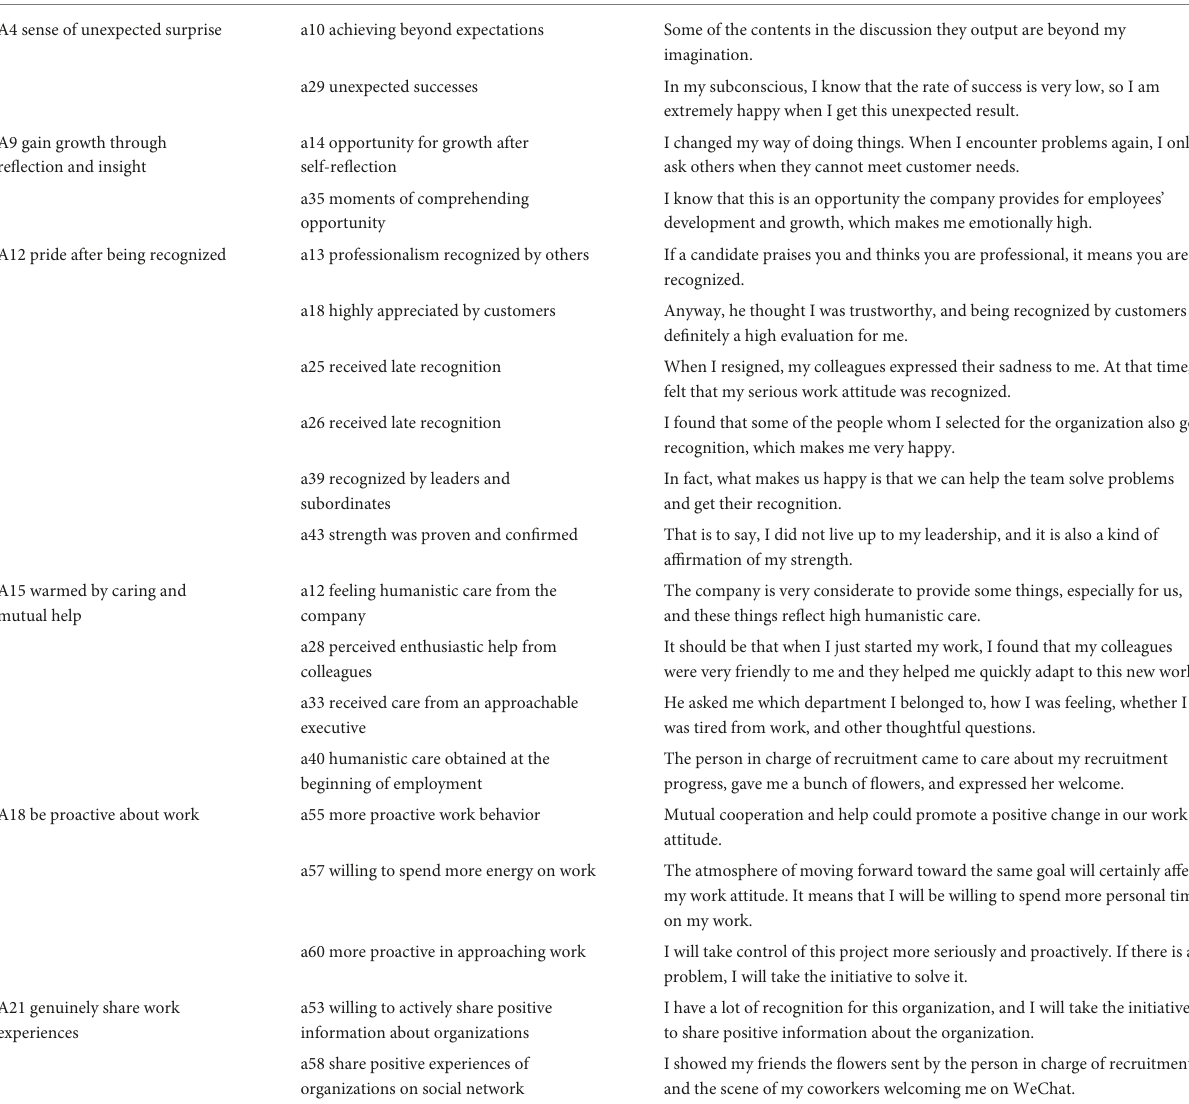
TABLE 2 Examples of open